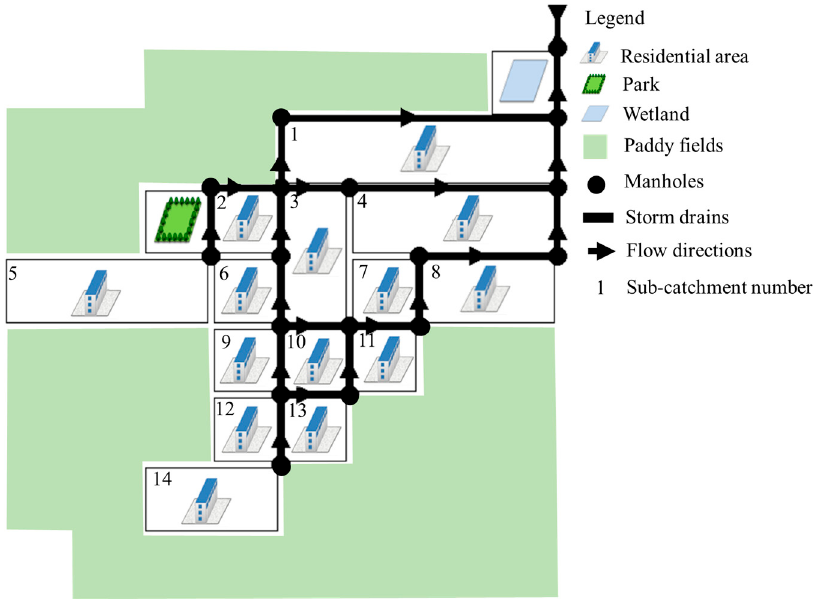
Figure 2. Location of the weather station and the study case of Xingshi Village, Hukou Township, Hsinchu County, northern Taiwan.